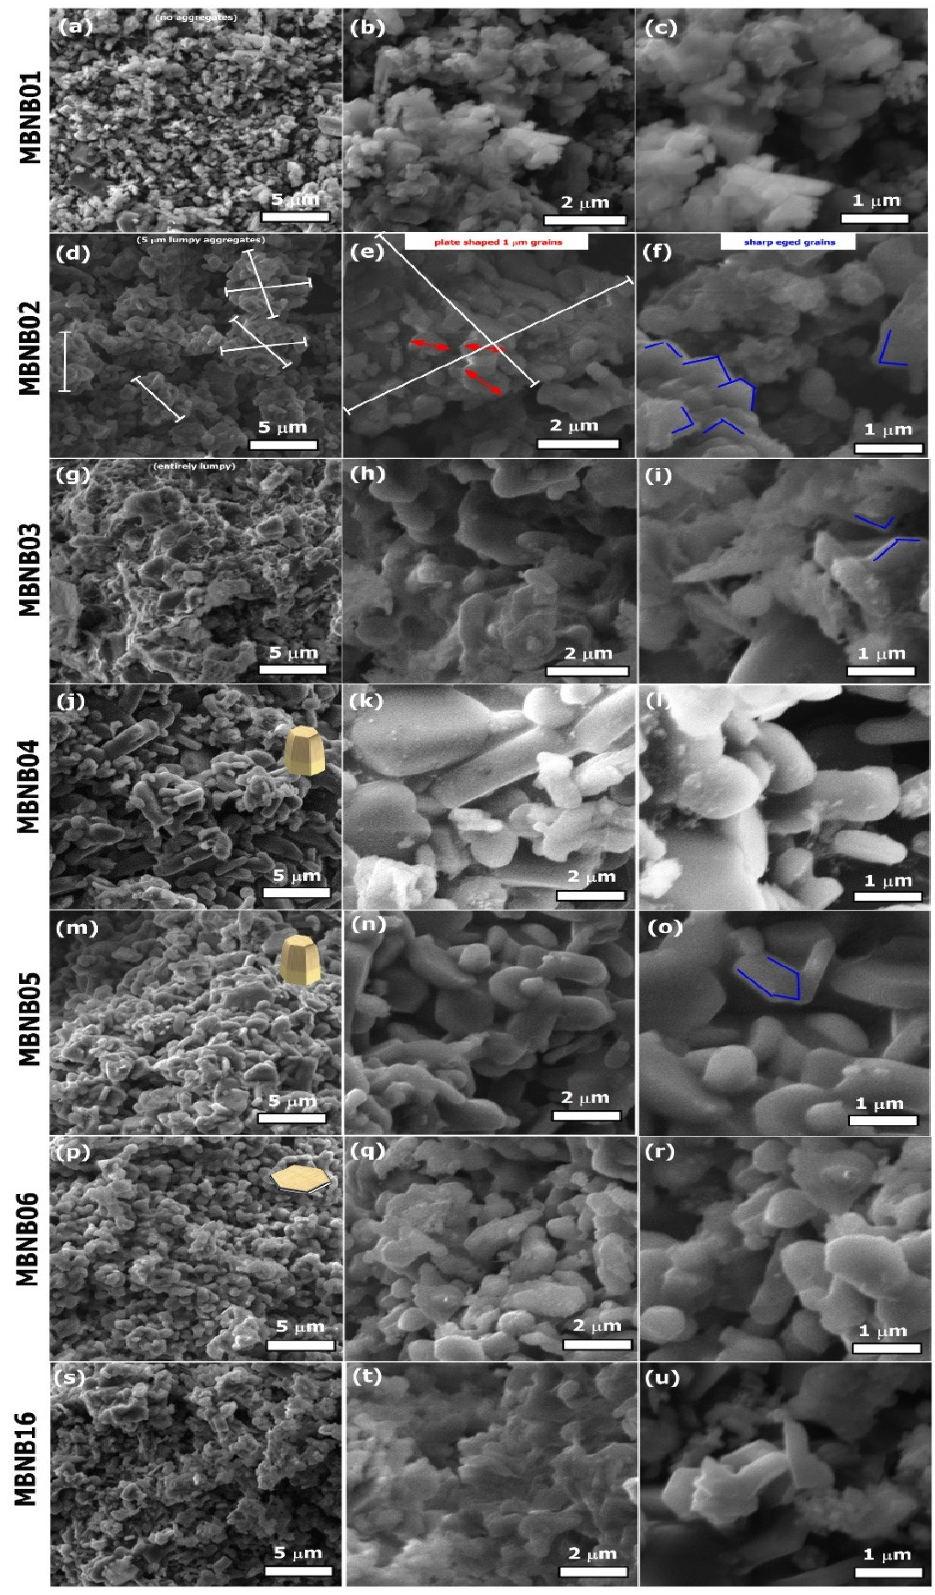
Figure 3. SEM images of the MgB 2 powders. Images of each row correspond to the sample indicated on the left (see Table 1). The three columns correspond to a magnification of 10 k×, 30 k×, and 50 k×, respectively.